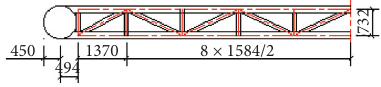
Figure 3: II-II section (unit: mm).